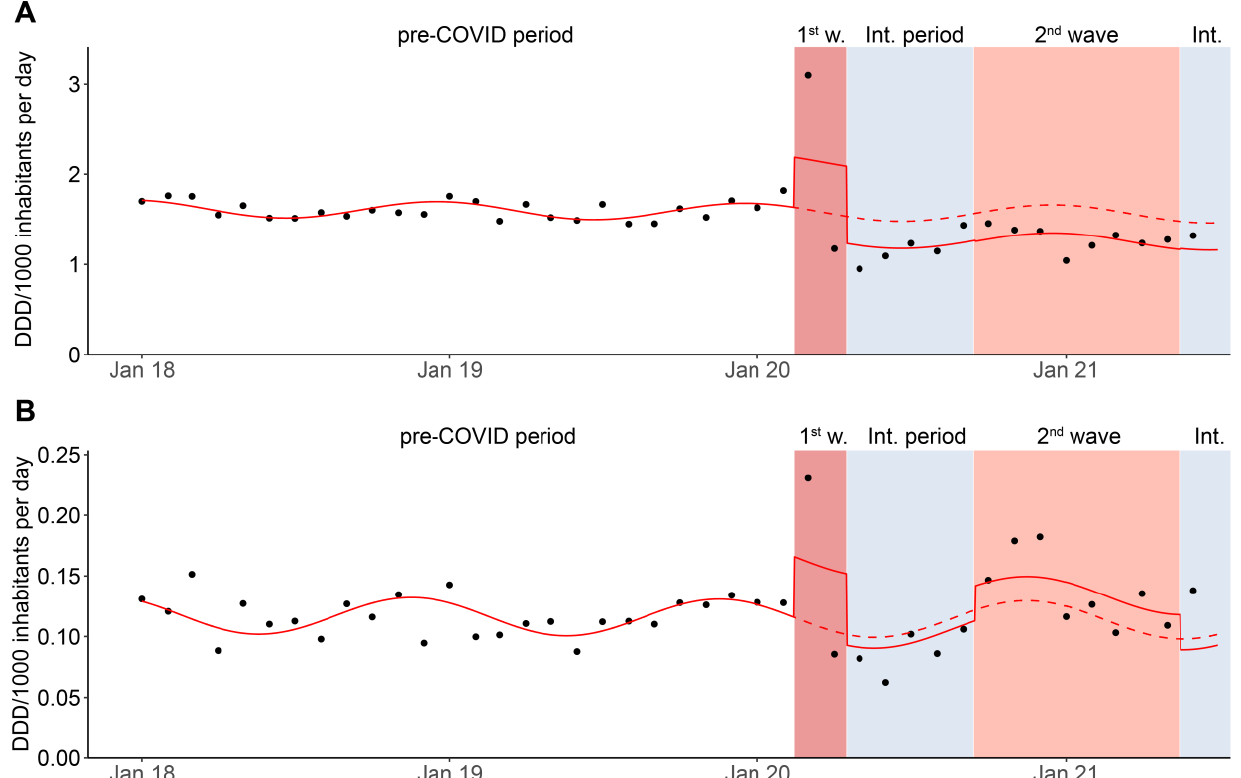
Figure 4. Monthly antibiotic consumption measured in DDD per 1000 inhabitants per day for ( A ) all antibiotics for systemic use (ATC code J01) and ( B ) broad-spectrum antibiotics between January 2018 and June 2021 (IQVIA data). The plot shows the impact of each pandemic phase (reddish background) on antibiotic consumption based on the segmented regression analysis. The solid line shows the estimates of the segmented regression model; the dotted line is the estimated regression model assuming the pandemic had not occurred. The dots show the effective consumption per month. Data source: IQVIA sales data (Sell-in) from pharmaceutical industries to the hospital sector. 1st w, 1st wave; Int. period., intermediate periods.